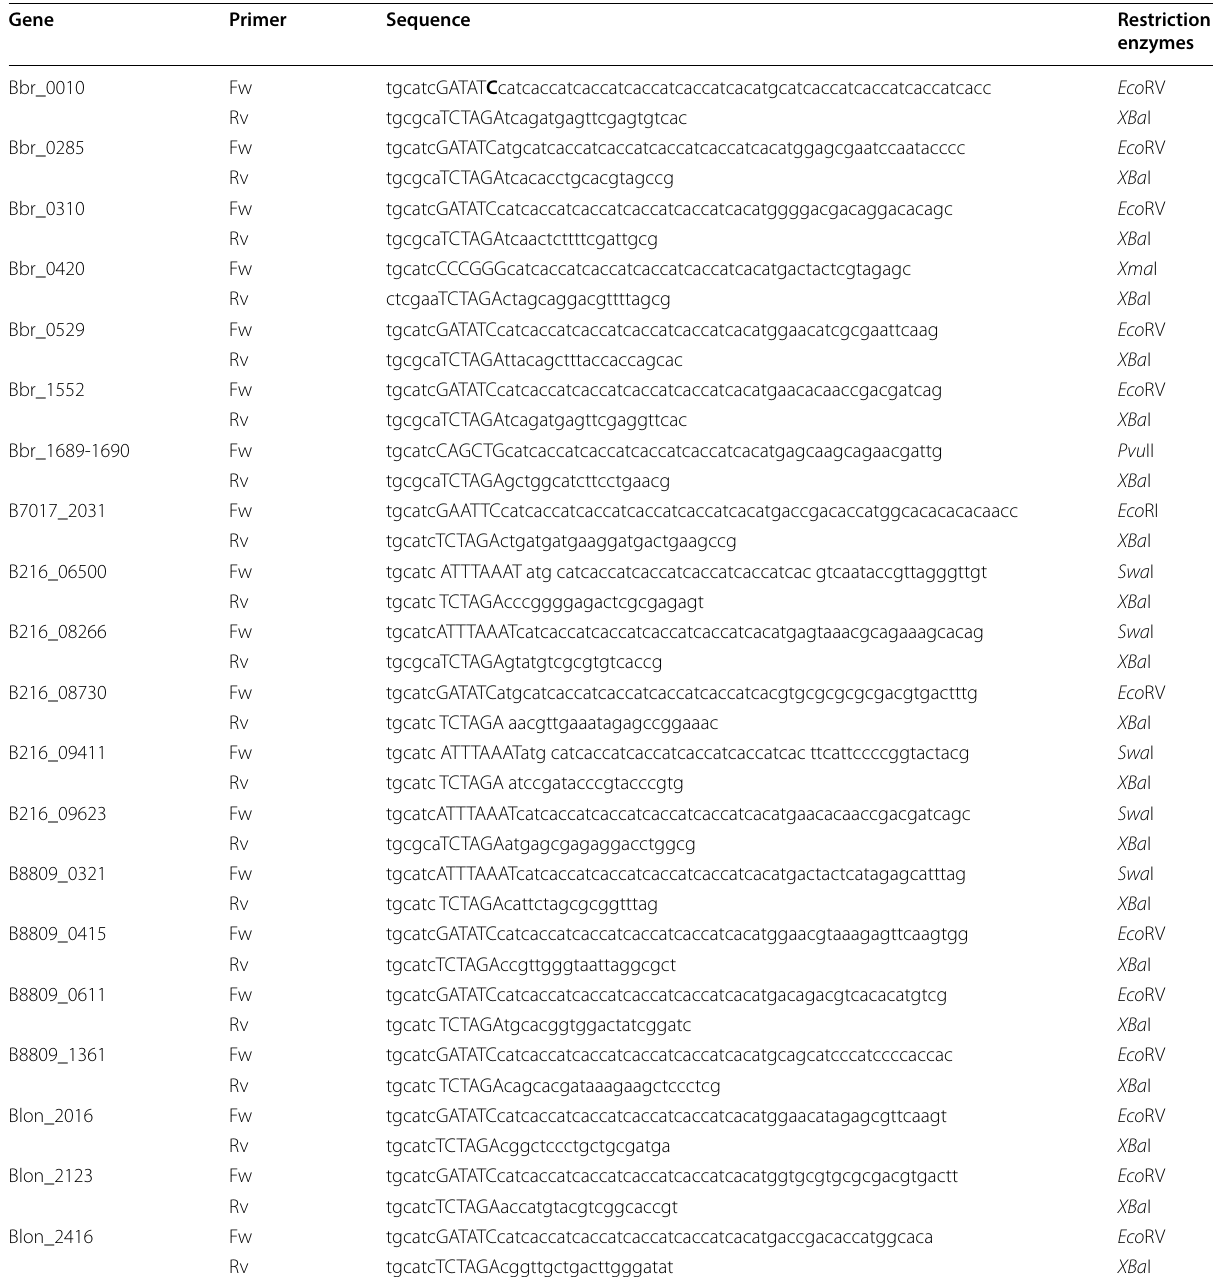
Table 2 Oligonucleotide primers used in this study Gene Primer Sequence Restriction